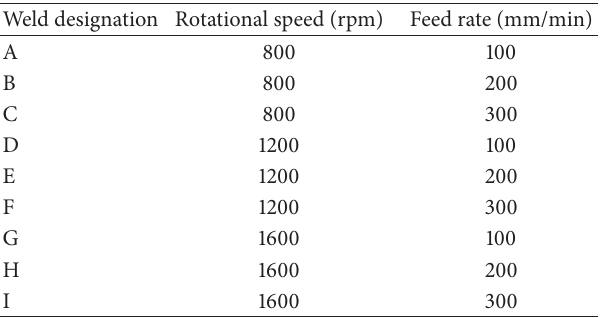
Table 2: Process parameter matrix of the